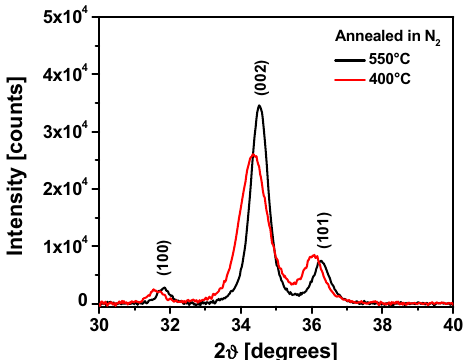
Fig. 4. X-ray diffraction patterns of ZnO:Ga films implanted with 1 × 10 16 cm − 2 , annealed in N 2 at 400 and 550 ◦ C.